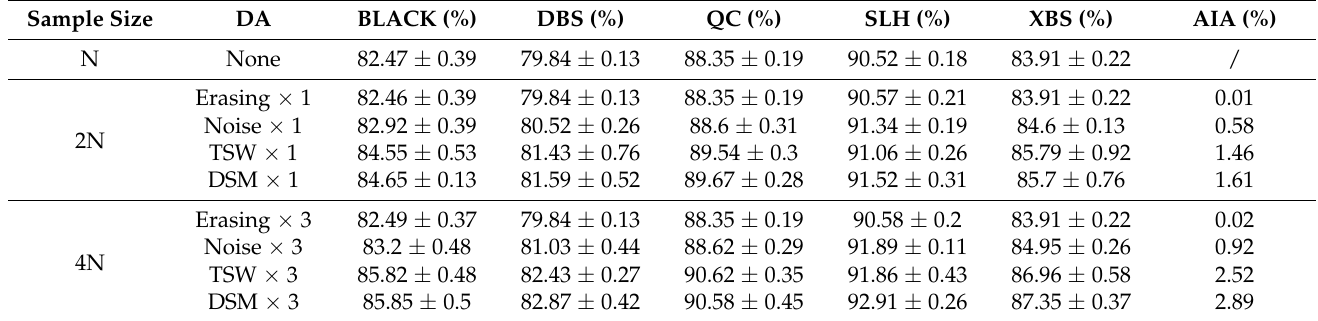
Table 5. Results of KNN training using all gradient